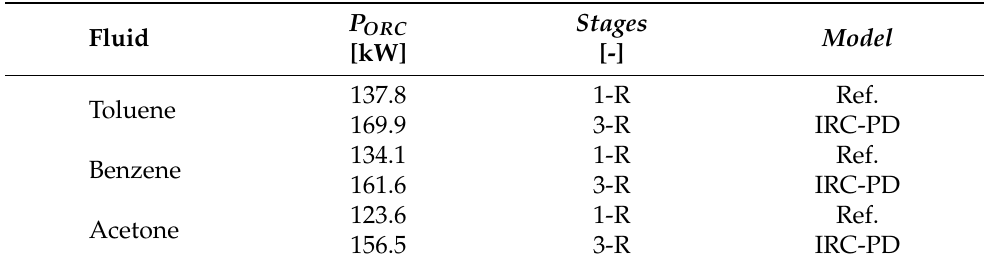
Table 5. Comparison between the results obtained with the IRC-PD tool using the same settings of ref. [17] but with the updated turbine’s